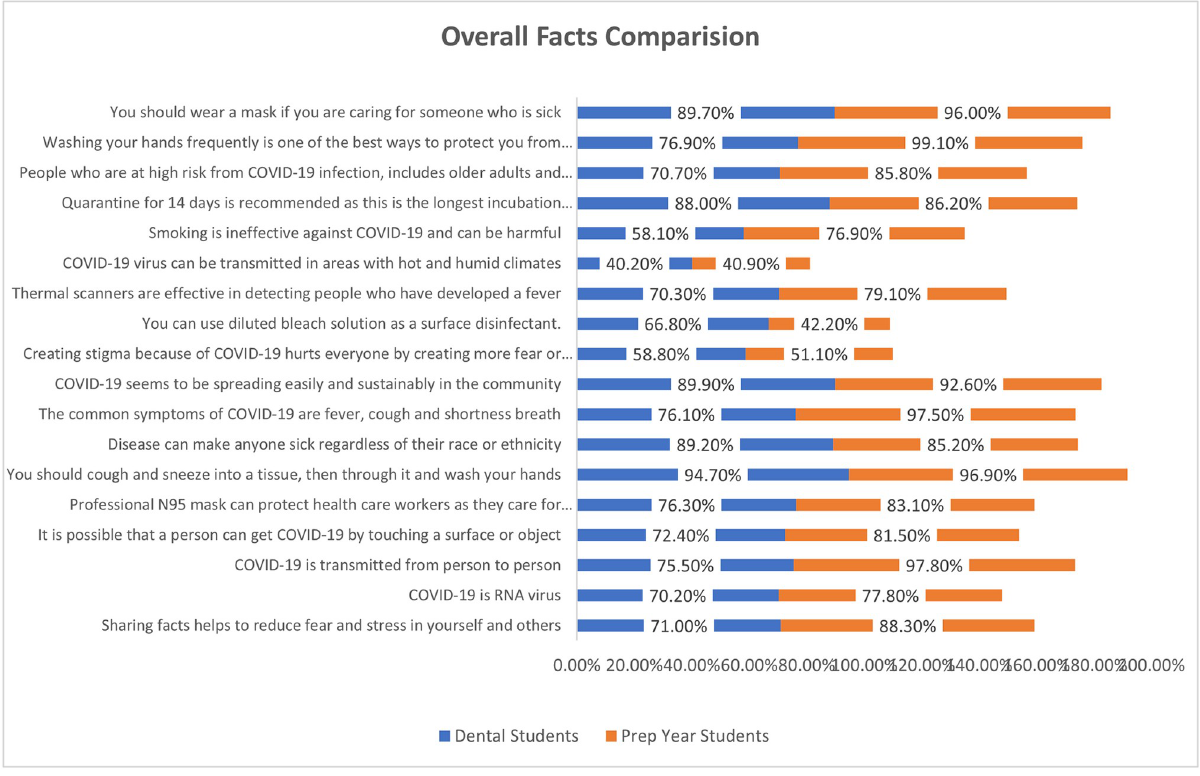
Fig 1. Overall facts comparison between dental and prep year